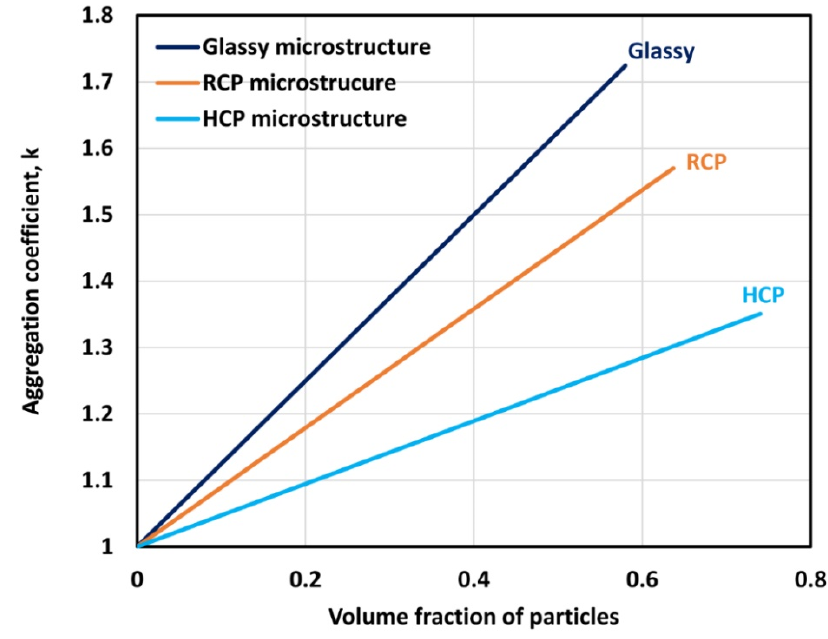
Figure 5. Variation of aggregation coe ffi cient k with φ for di ff erent packing arrangement of particles within clusters.